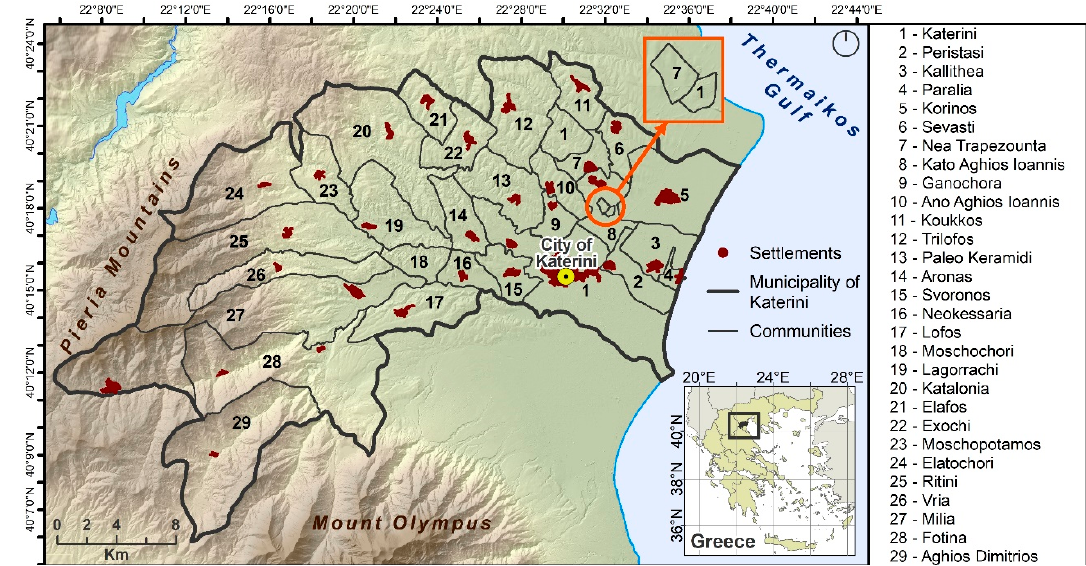
Figure 1. Municipality of Katerini and local administrative units (LAUs). LAUs are described by ID in Table 1. Table 1. Population, area and density by LAU,